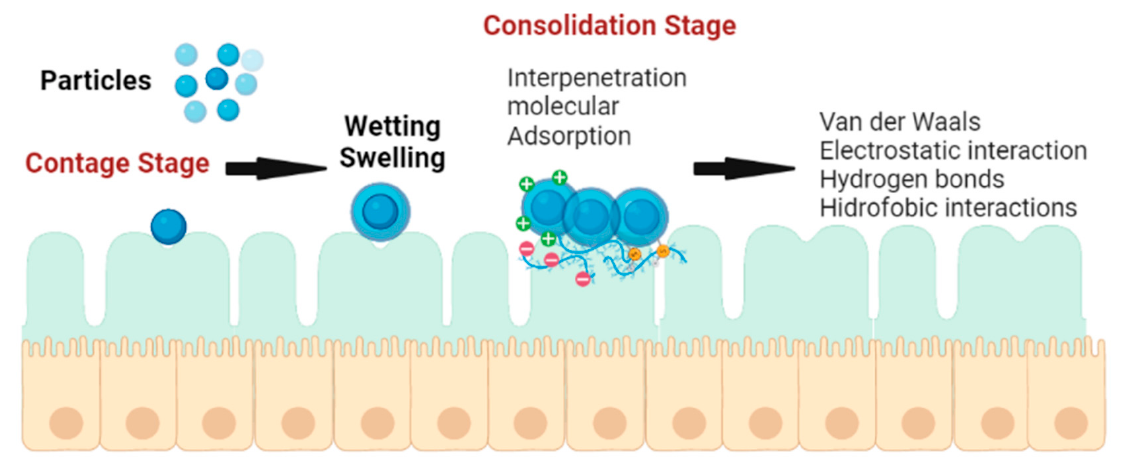
Figure 2. Mucoadhesion of polymeric particles to mucous membranes. First, an intimate interaction between polymeric particles and the mucous membrane occurs in the contact stage, with subsequent wetting and swelling. Later, in the state of consolidation, physicochemical interactions enable the adsorption and molecular interpenetration of polymer chains into the mucus layer that covers the epithelial surface, eventually leading to prolonged adhesion.